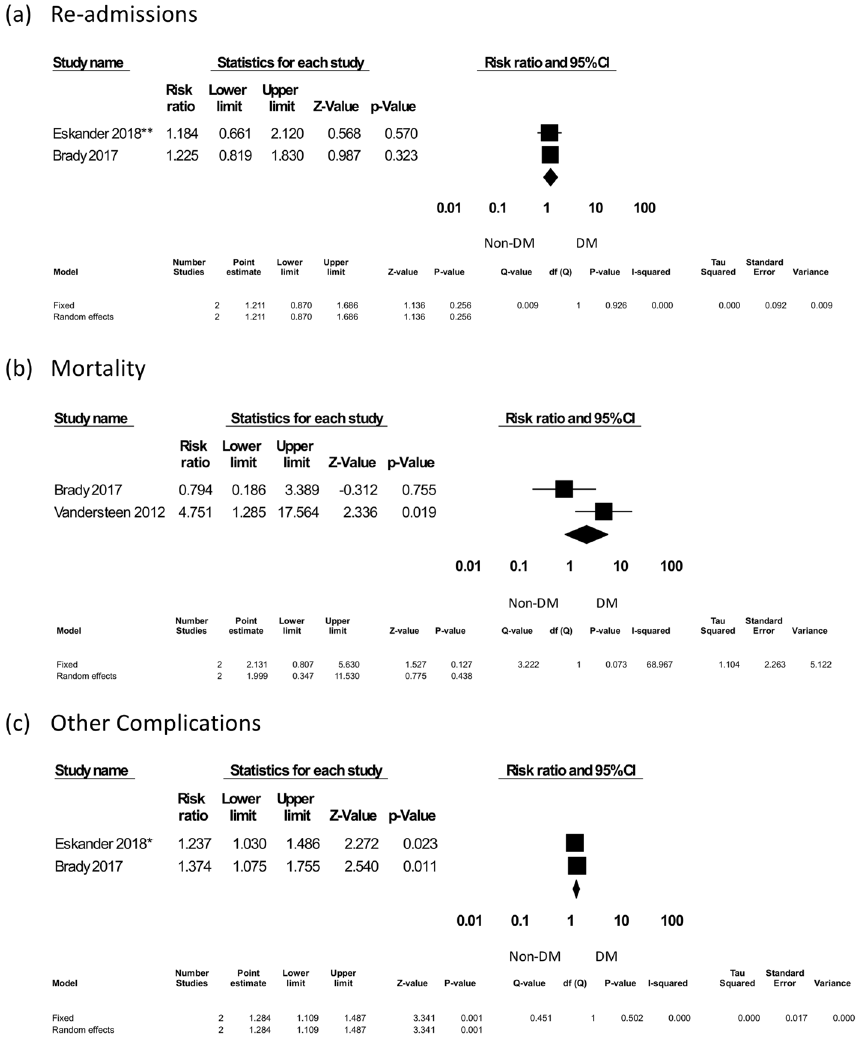
Figure 6. Quality aspects: readmissions, mortality, and other complications. *Eskander 32 , **Eskander 35 . Other complications include myocardial infarction, cerebrovascular event, deep vein thrombosis, pulmonary embolism, pneumonia, urinary tract infection, and septic